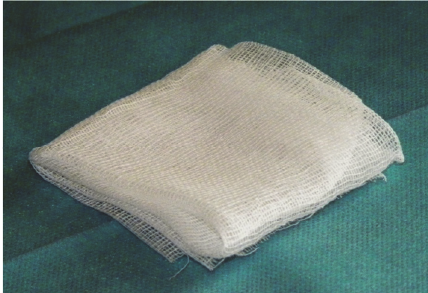
Figure 3: Braided-mesh